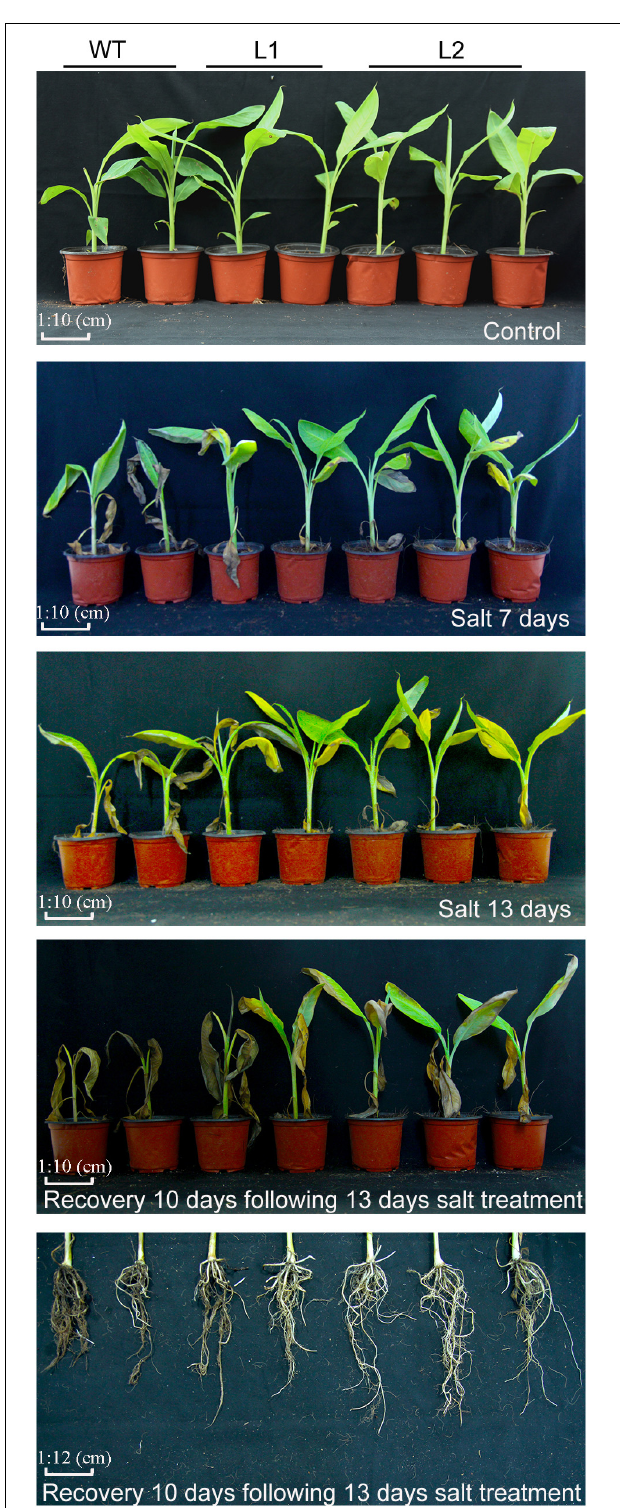
FIGURE 5 | Phenotype differences between WT and transgenic plants under normal, salt, and recovery conditions. Banana seedlings (100-day-old) were subjected to salt treatment (250 mM NaCl) for 7 and 13 days, and recovery for 10 days following 13 days salt treatment, then the photos were